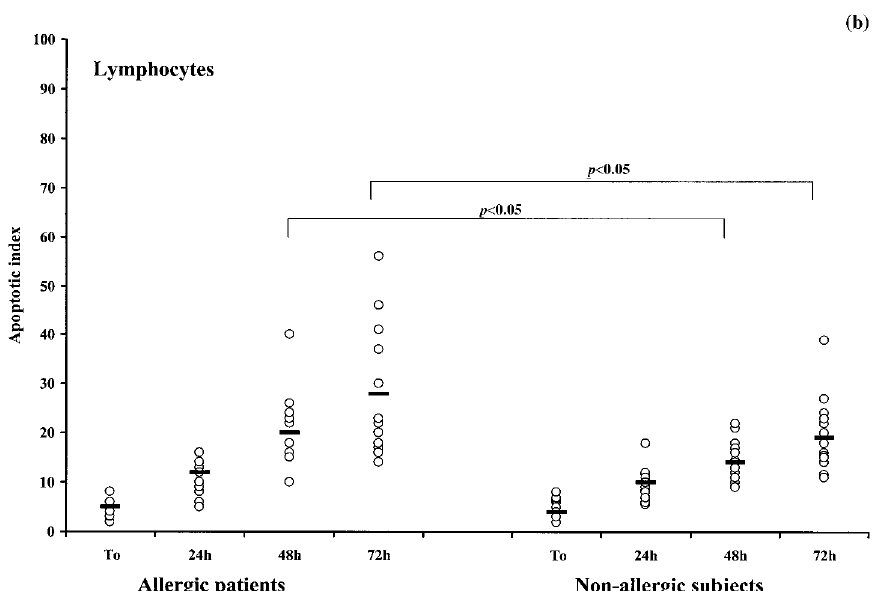
FIG. 2 Spontaneous apoptosis of cells in allergic and non-allergic subjects; (–) mean value; (a) Unfractionated mononuclear cells (MNC); (b)